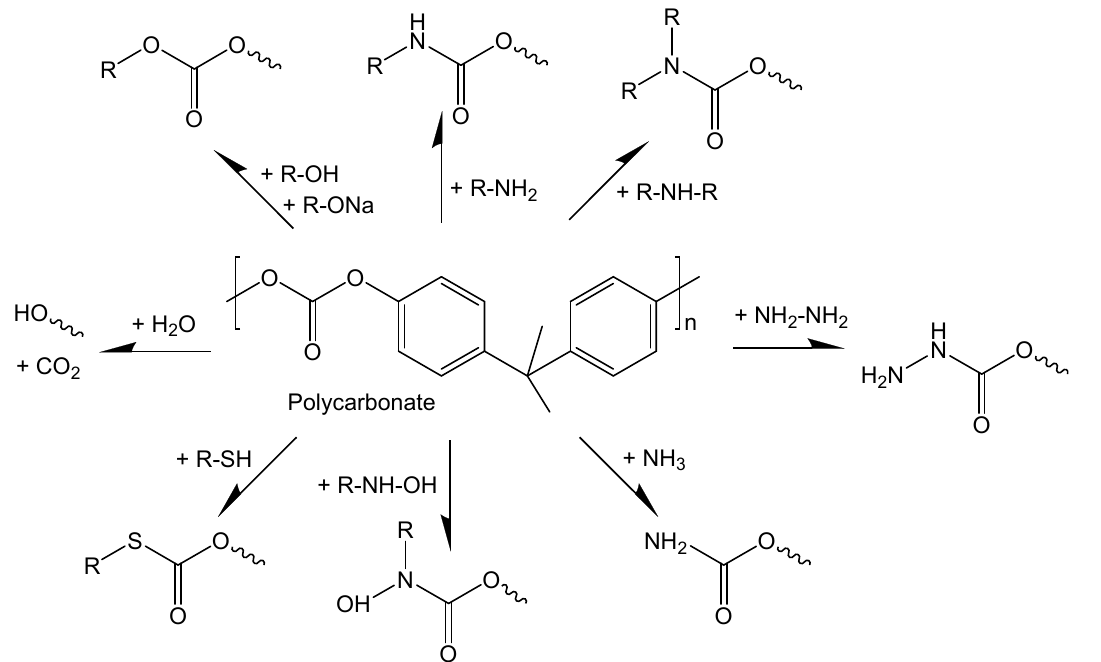
Figure 3. Scheme of chemical reactions for PC with different components.